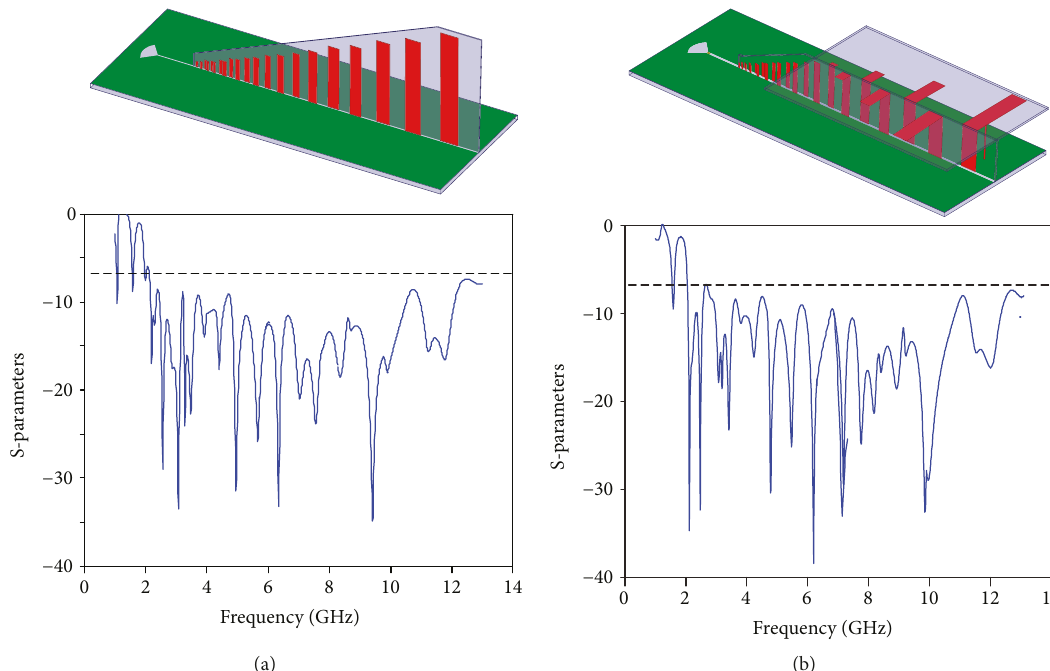
Figure 4: Structure and port re fl ections of (a) original and (b) low-pro fi le wideband log-period monopole end- fi re